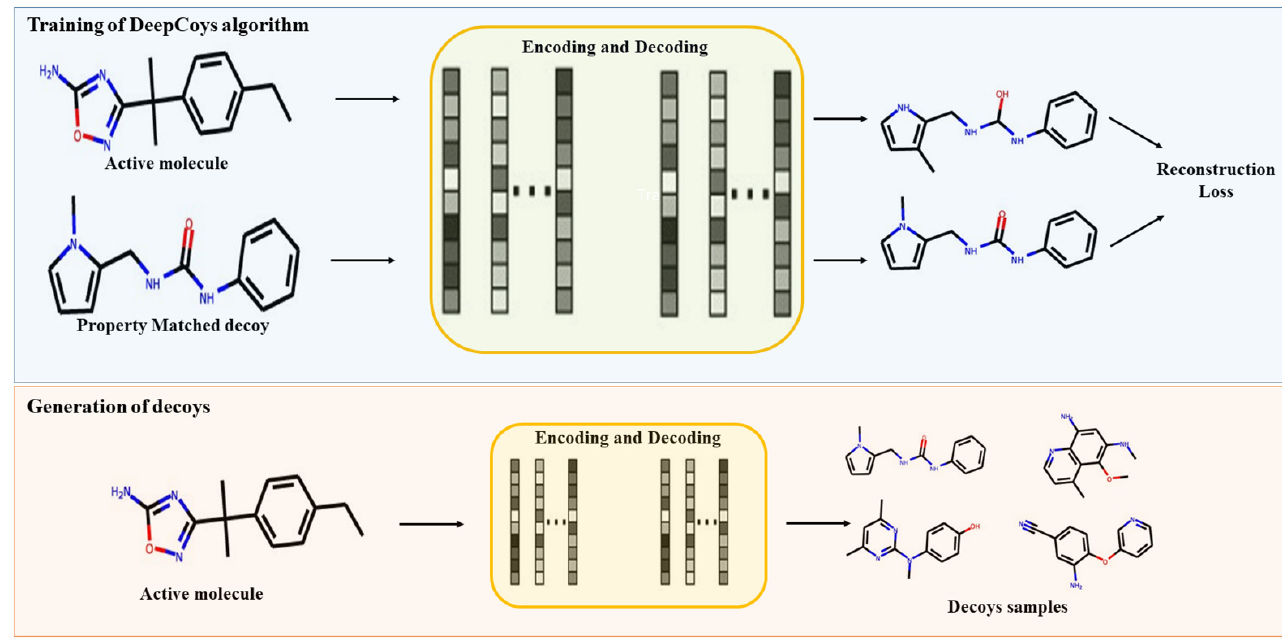
Figure 9. Decoys generation process through DeepCoys algorithm. The figure was adapted from